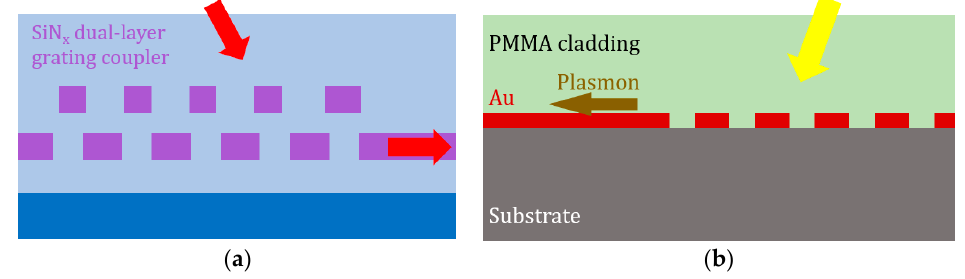
Figure 10. ( a ) Dual ‐ layer SiN ‐ on ‐ SiN GC; and ( b ) metal GC that excites surface